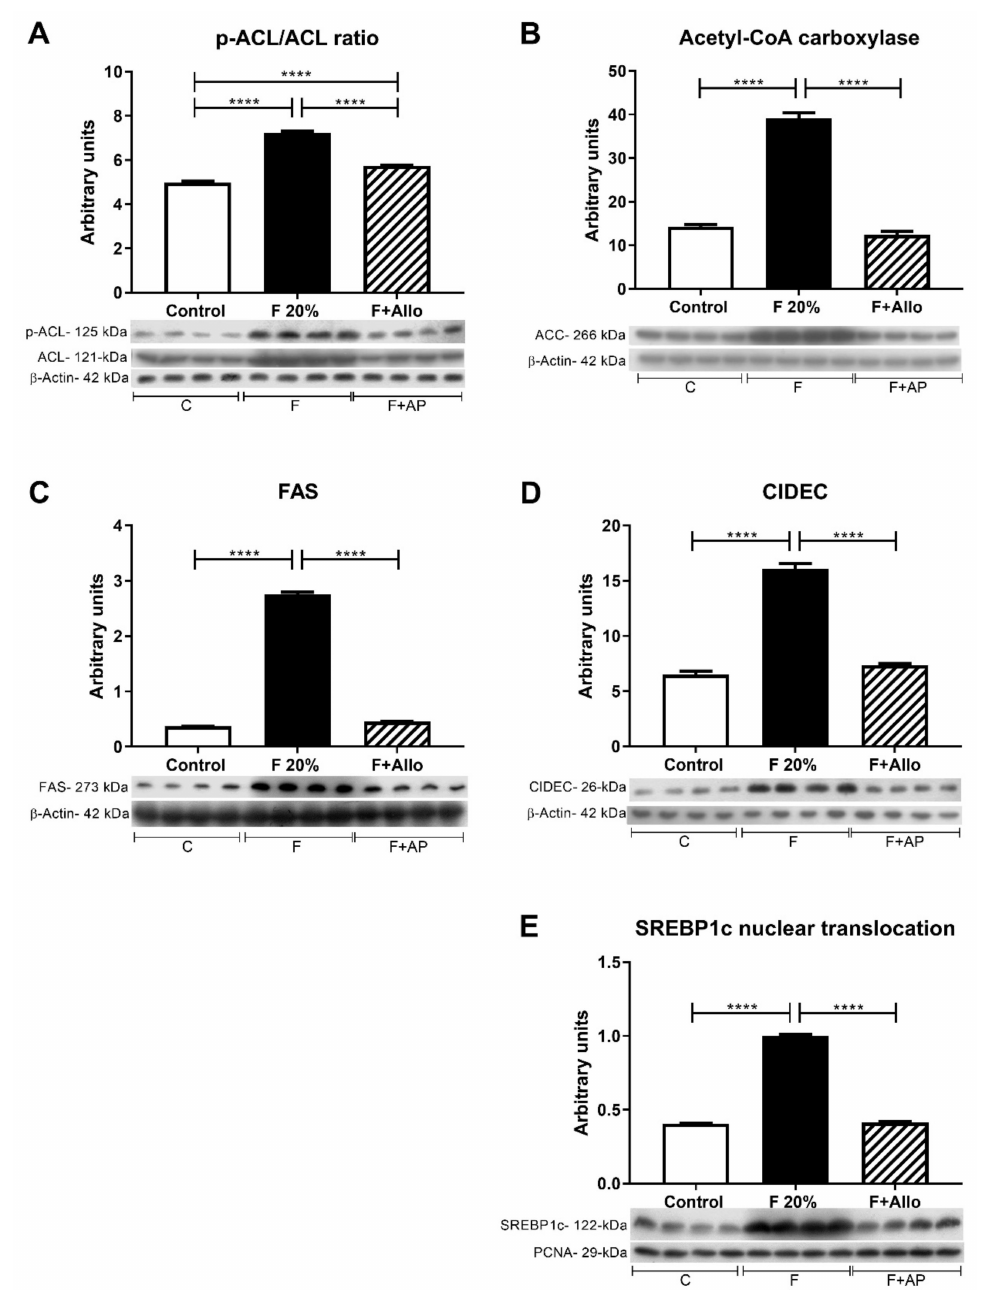
Figure 4. Markers of lipid metabolism after an acute load of fructose. In high fructose fed rats challenged with and acute load of fructose, there was an increased activation of ATP citrate lyase ( A ) and acetyl CoA carboxylase ( B ) as well as an increased expression of fatty acid synthase ( C ) and CIDEC ( D ). These e ff ects were in parallel with an increased nuclear translocation of the transcription factor SREBP1c ( E ). Allopurinol treatment prevented all these e ff ects. For western blotting, 4 out of 5 randomly selected samples per group were analyzed. **** = p <